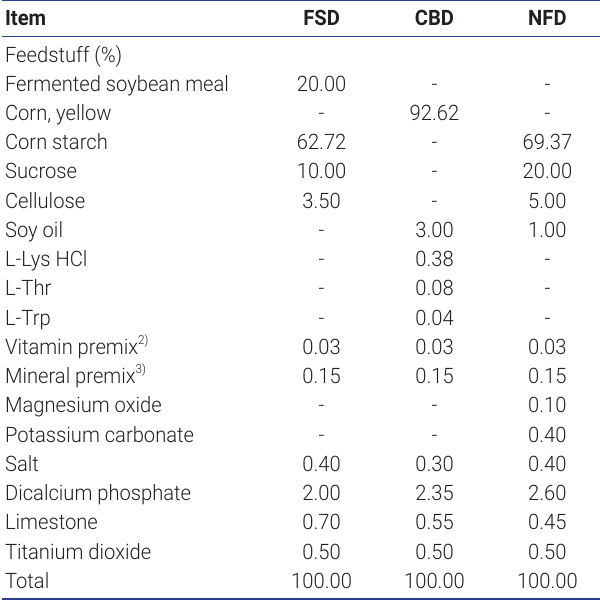
Table 1. Composition of experimental diets 1) (as-fed